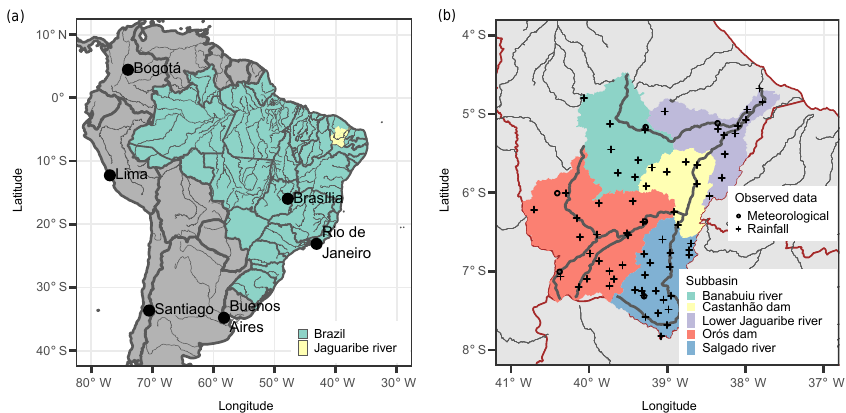
Figure 2. Left panel shows the location of the Jaguaribe River basin in South America. Right panel shows the Jaguaribe River together with its main tributaries, division into subcatchments used in this work, and meteorological and rainfall observation